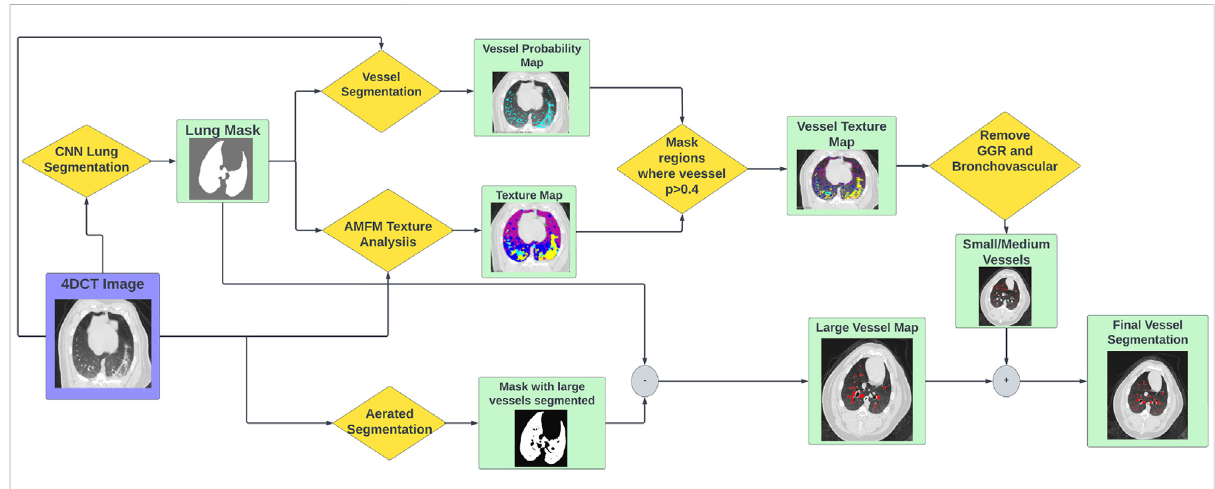
FIGURE 3 Flowchart showing the work fl ow to produce vascular segmentations using the tools